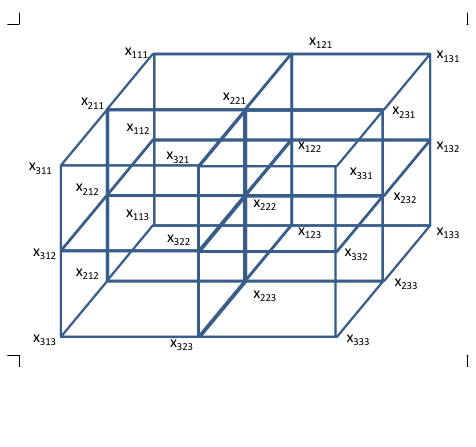
Figure 3: Geometrical Structure of 2 × 3 × 3 Contingency